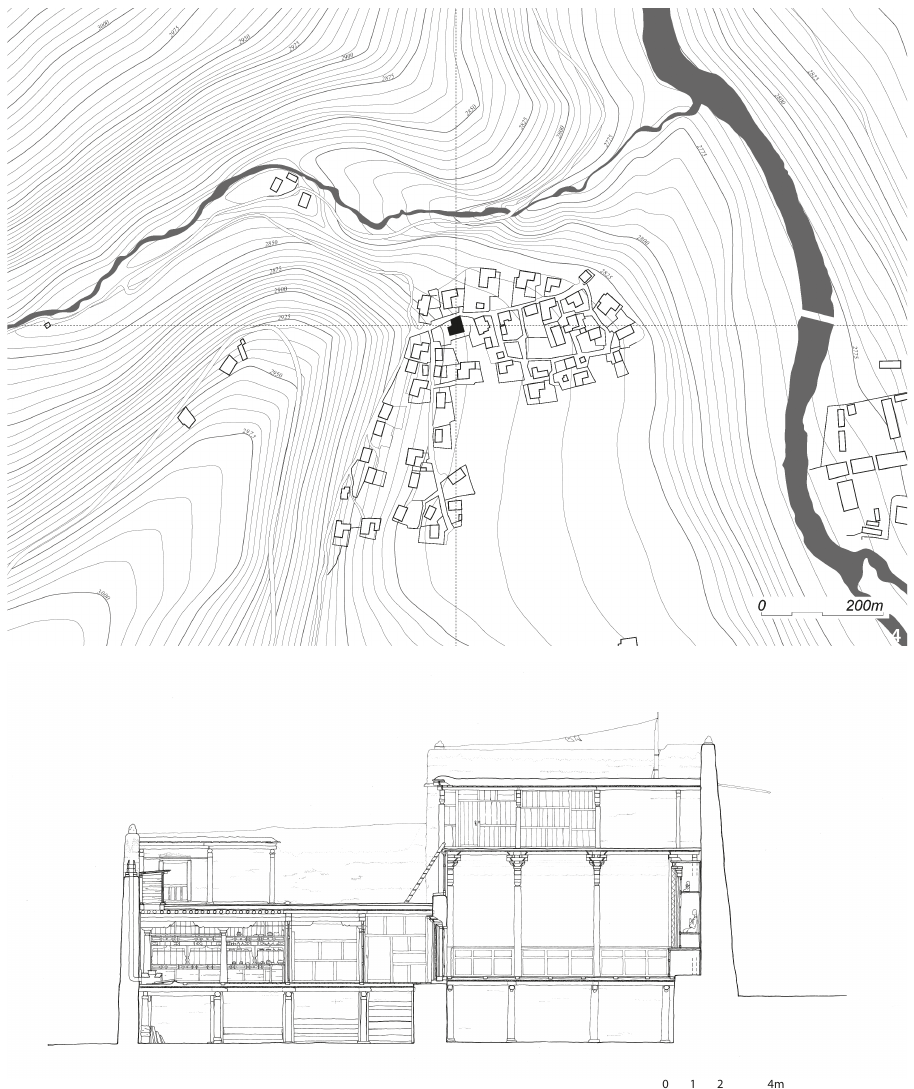
Figure 4 Site plan of the farm- house in Chatreng (Source: the authors). Figure 5 Section A–A through the sacred room of the farmhouse in Chatreng (Source: the authors).